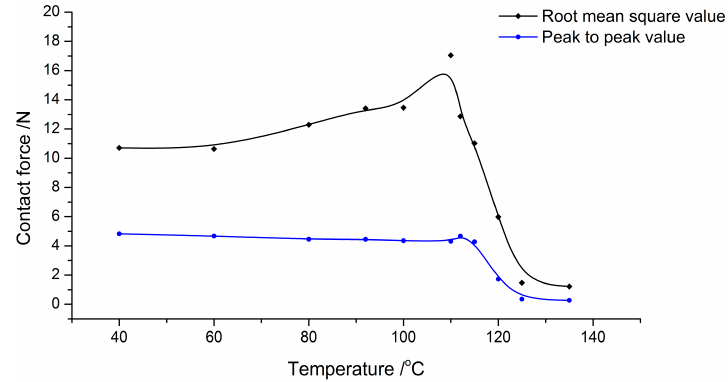
Figure 5. Root mean square value and peak to peak value of F s-a , corresponding to temperature.